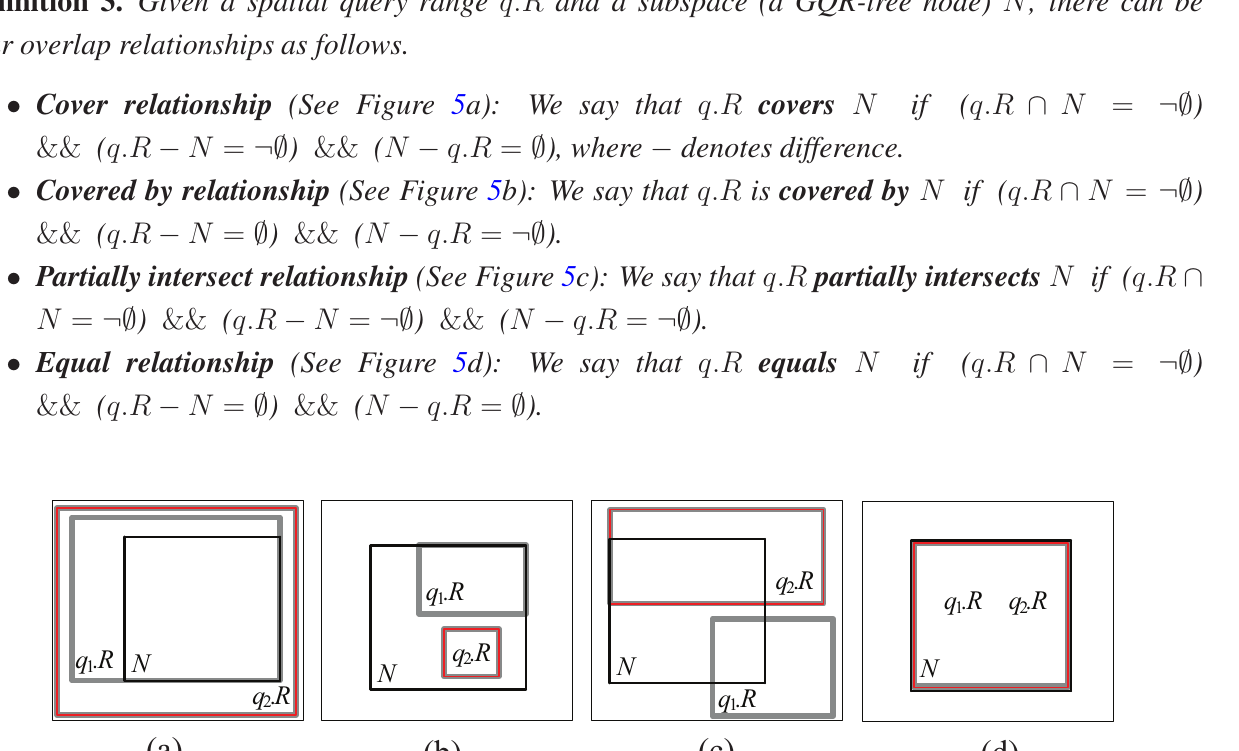
Figure 5. Classification of the overlap relationship. ( a ) q